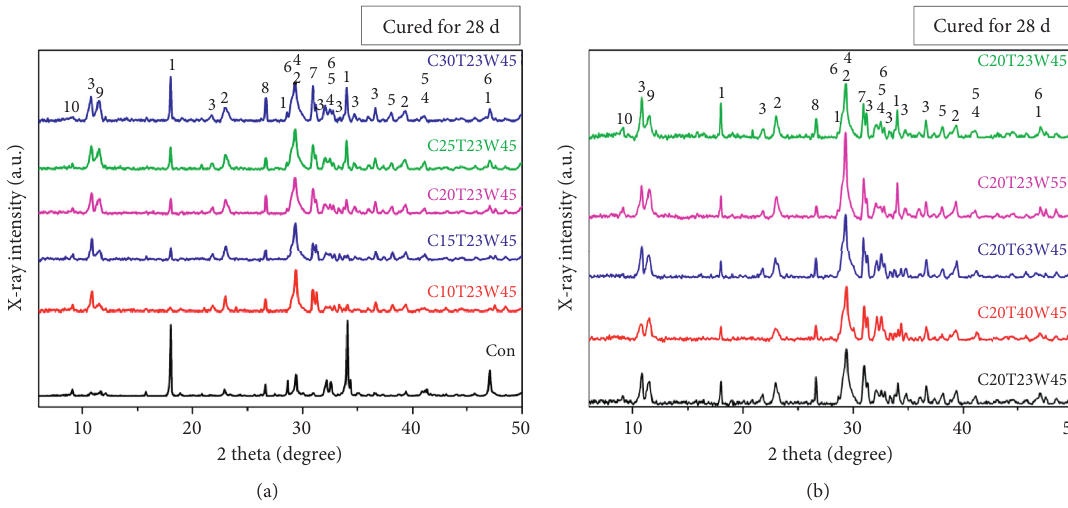
Figure 3: XRD patterns of 28d pastes ((1) CH, (2) calcite, (3) hydrocalumite, (4) C (9) hydrotalcite, and (10) AFt).